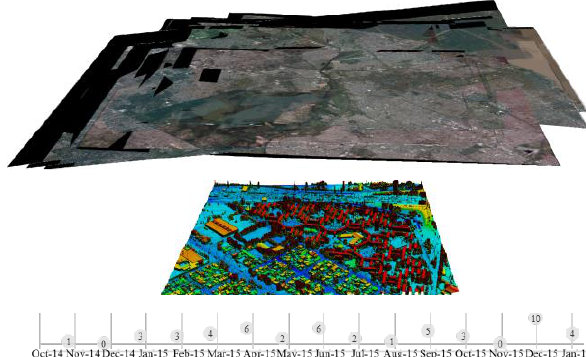
Figure 1. Overview of the 50 Multi-view WorldView-3 images in two years (above), and the acquired LiDAR-DSM (middle). The imaging time is summarized